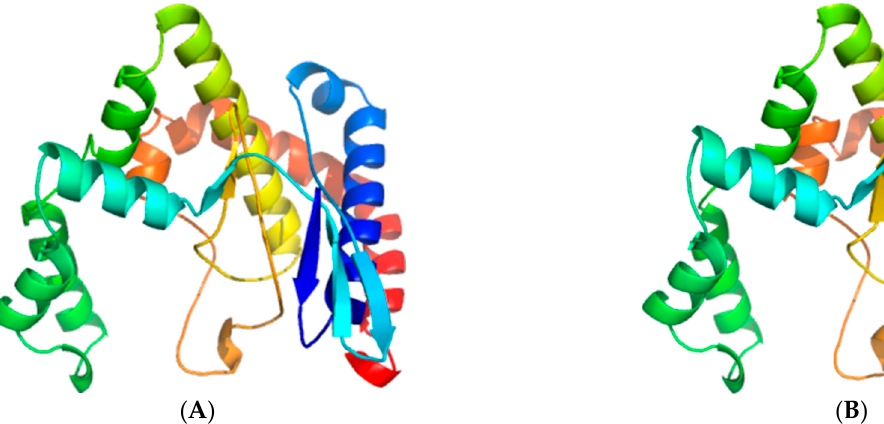
Figure 6. Predicted tertiary structure for the kinase domain (PIKKc) of both TOR-like amoebic proteins. Best 3D model (ribbon representation) for the PIKKc: Eh FRAP ( A ) and Eh TOR2 ( B ). Rainbow-colored from amino (blue) to carboxy (red).